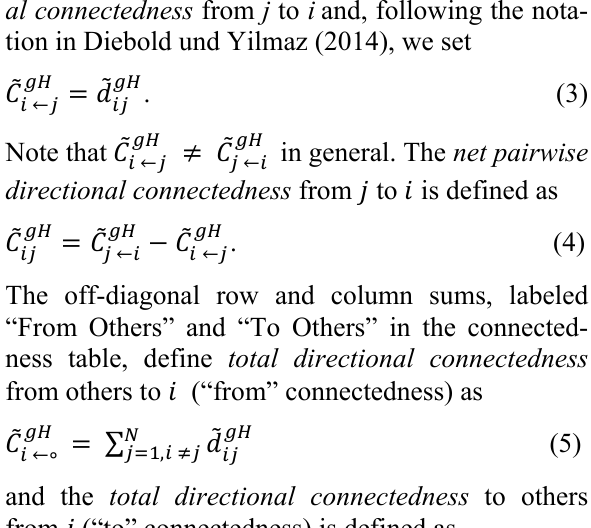
The off-diagonal row and column sums,